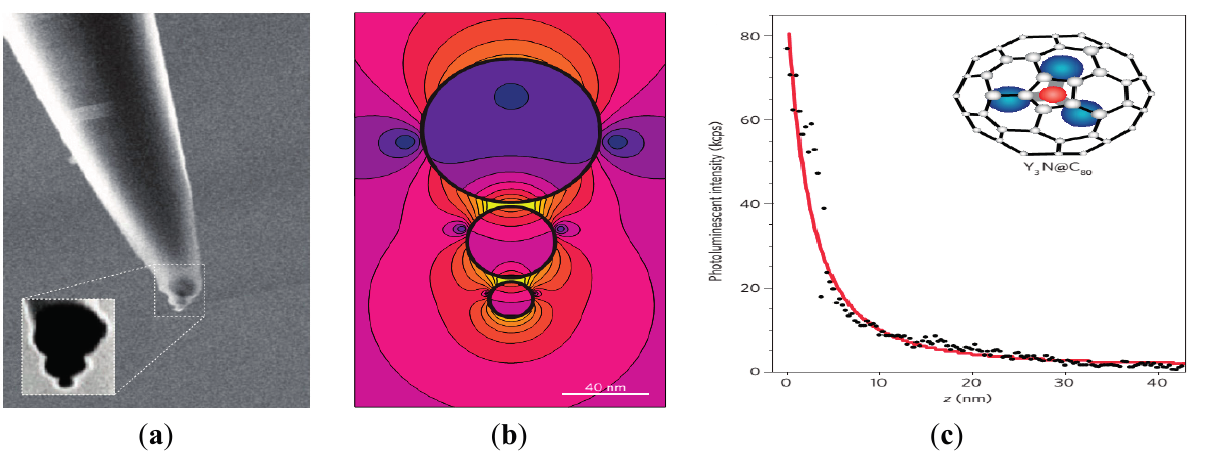
Figure 4. Sample of optical antenna using bottom-up fabrication. ( a ) SEM image of a gold trimer antenna; ( b ) intensity nearby a trimer antenna at 650 nm wavelength; ( c ) Fluorescence from a metallofullerene